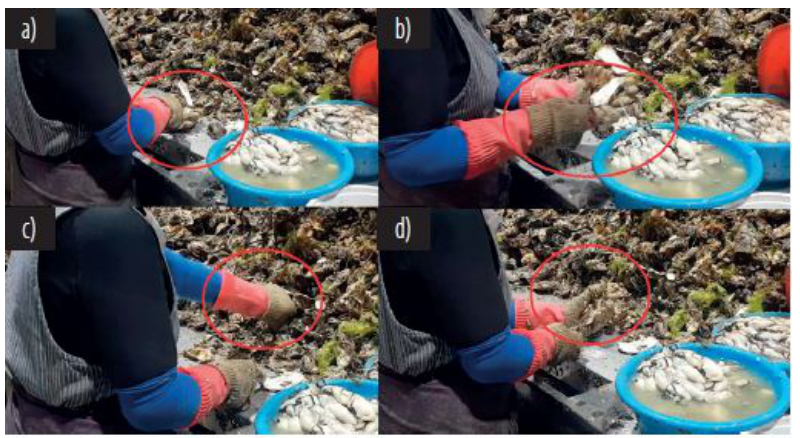
Figure 10. The movement of the hand during oyster shucker’s work. Right hand holding the knife experienced repeated “dart throw motion”: ( a ) wrist ulnar deviation + flexion; ( b ) wrist radial deviation + flexion. The other hand holding the oyster experienced repeated: ( c ) wrist flexion; ( d ) wrist extension. Reprinted/adapted with permission from J. S. Park et al. [28], published by Nofer